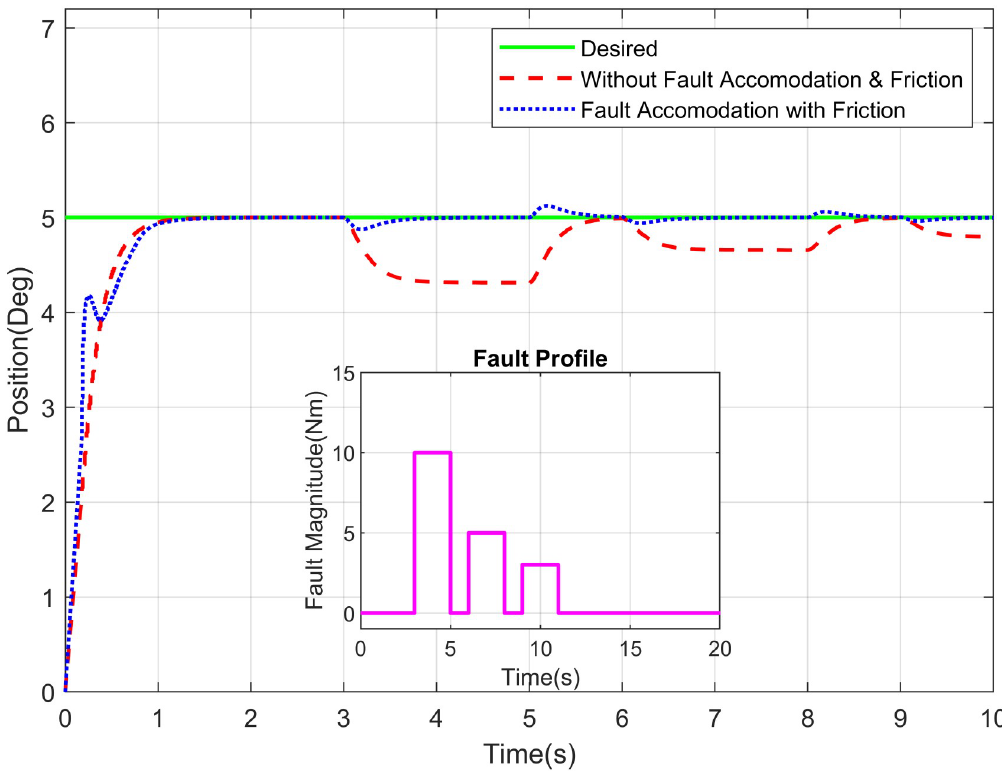
Fig 11. Position tracking of shoulder joint of a robot manipulator with intermittent fault